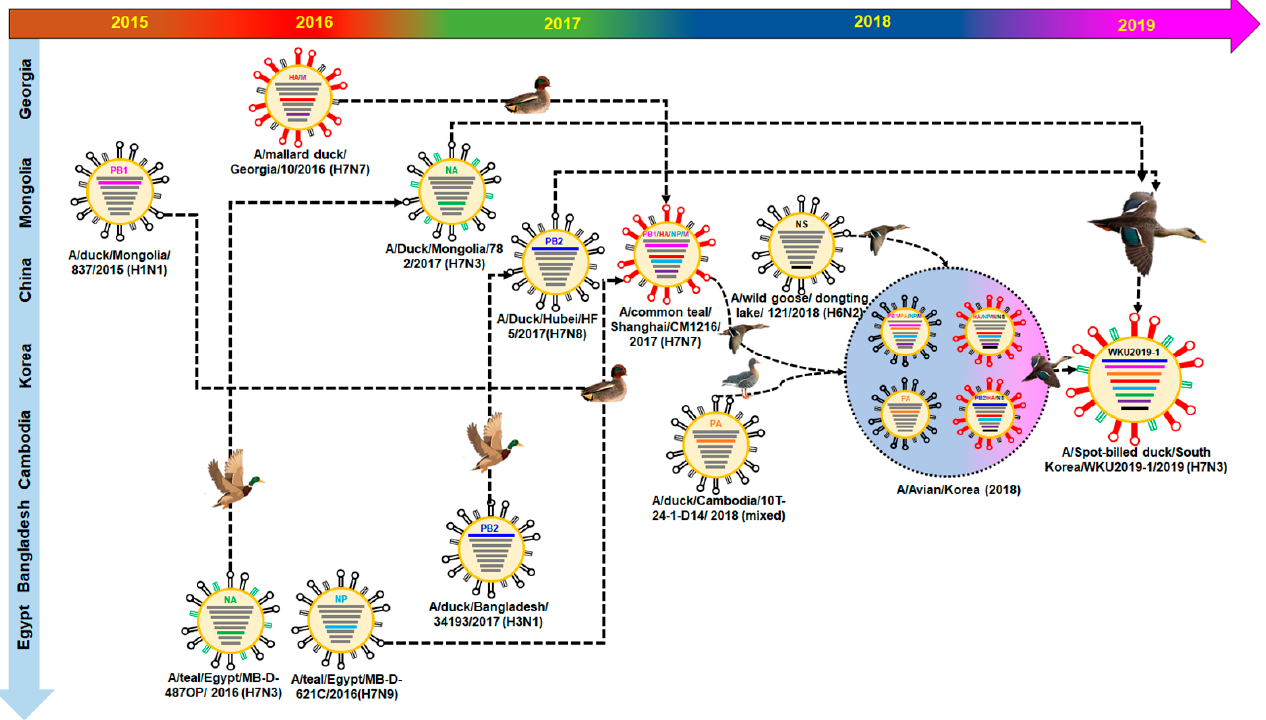
Figure 2. Locations of the putative origin of genomic compositions of the H7N3 (WKU2019-1).